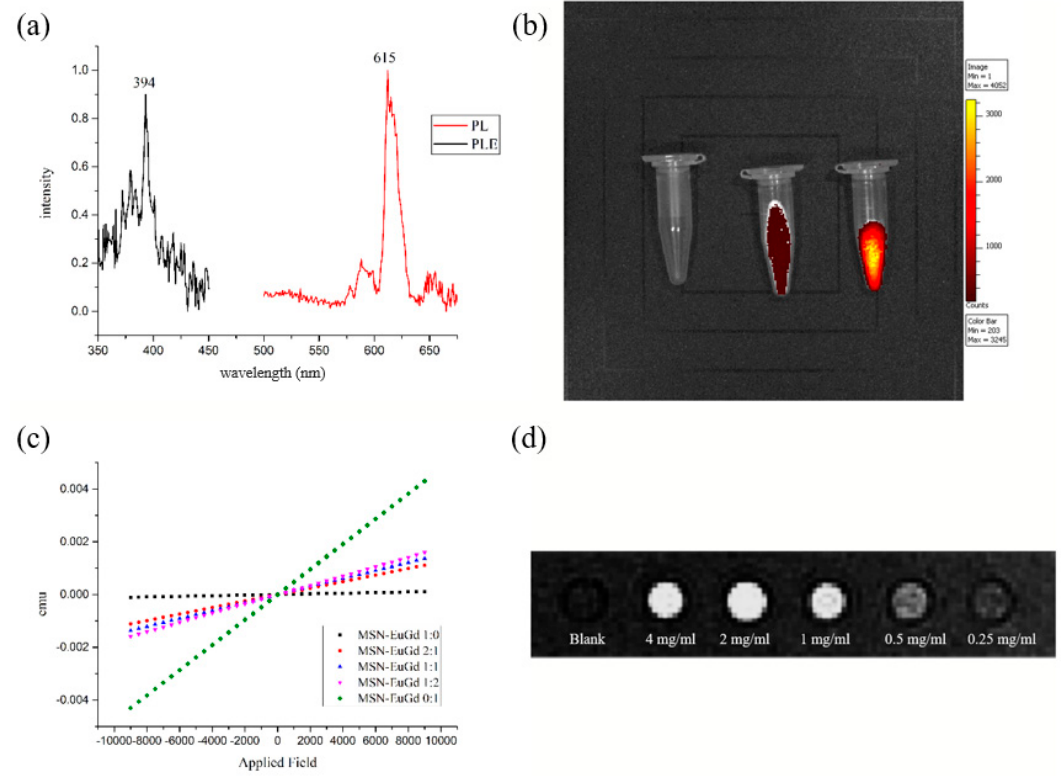
Figure 2. ( a ) PLE and PL results showing emission spectra of the MSN-EuGd. ( b ) IVIS optical imaging of Blank, MSN, and MSN-EuGd. ( c ) The magnetization curves of MSN-EuGd. ( d ) of Blank, MSN, and MSN-EuGd. ( c ) The magnetization curves of MSN-EuGd. ( d ) T 1 -weighted MRI T 1 -weighted MRI of MSN-EuGd. of